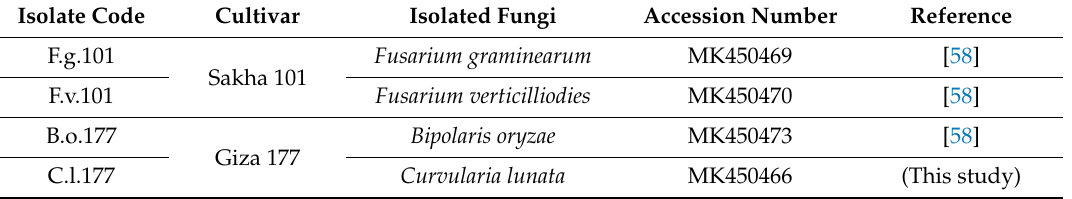
Table 5. Fungal isolates obtained from discolored rice grains and Genbank accession number codes.